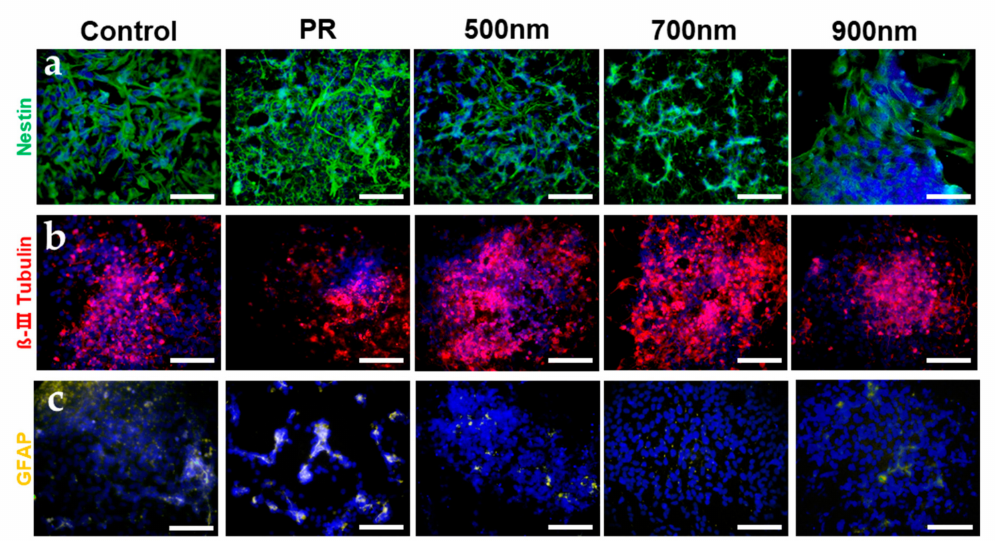
Figure 6. Immunofluorescence staining upon neural di ff erentiation of mNSCs with ( a ) nestin as an undi ff erentiation marker, and ( b ) β -III Tubulin (beta -III; Tubulin) and ( c ) GFAP (Glial fibrillary acidic protein) as di ff erentiation markers. Pseudo-colored fluorescent images of mNSCs were done for Figure C. Control = bare ITO substrate; scale bar = 100 µ